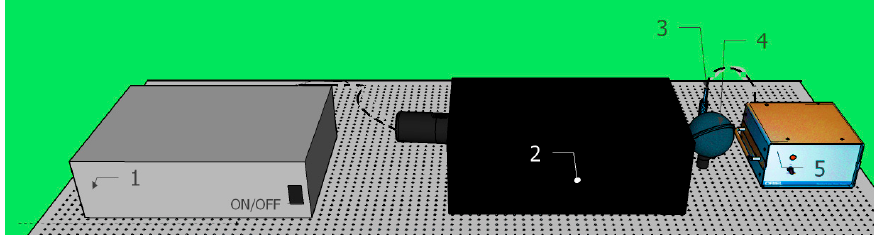
Figure 7. Narrow band spectral calibration source (OL750D double monochromator) characterization setup using multiple pencil-type reference lamps: (1) OL750D controller; (2) double monochromator OL750D from Gooch & Housego; (3) pen-ray emission lamp (Ne/Ar); (4) NERC 6” integrating sphere optimized for pen-ray lamp entrance to improve the signal at the monochromator entrance; (5) pen-ray lamps’ power supply unit.